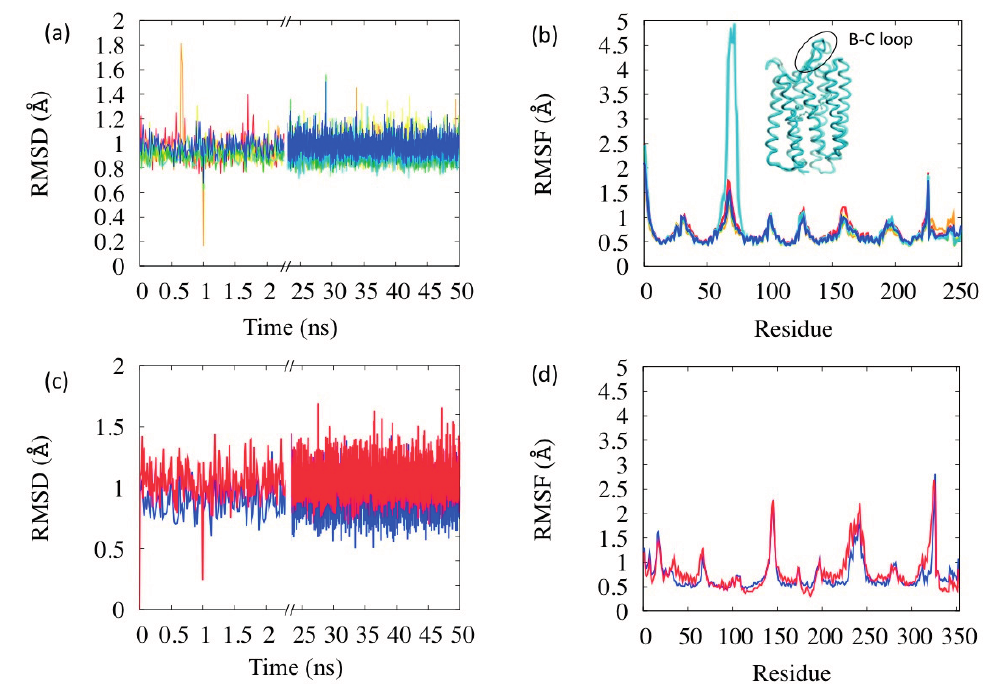
Figure 5. Simulations of the six BR photocycle states ( a ) RSMD and ( b ) RSMF. Color codes: Red = BR, orange = K, yellow = L, green = M, cyan = N, blue = O. The inset in (b) is a representative structure of the N state with B-C loop highlighted. Simulations of the